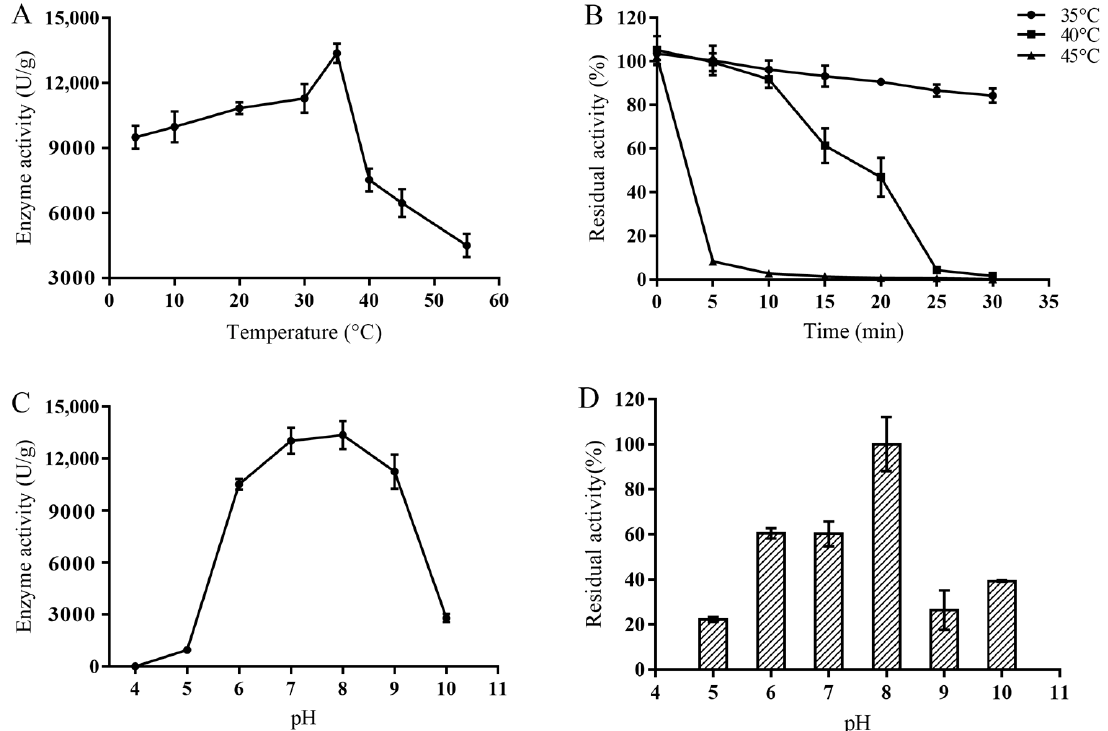
Figure 1. Enzymatic characterization of recombinant wild-type MsPLD. ( A ) Effects of temperature on enzyme activity. ( B ) Thermal stability of MsPLD under various temperatures. ( C ) Effects of different pH on enzyme activity. ( D ) pH stability of MsPLD. Results are expressed as mean ± SD (bars) of three independent experiments. The residual activity was calculated by defining the highest activity of samples as 100%.